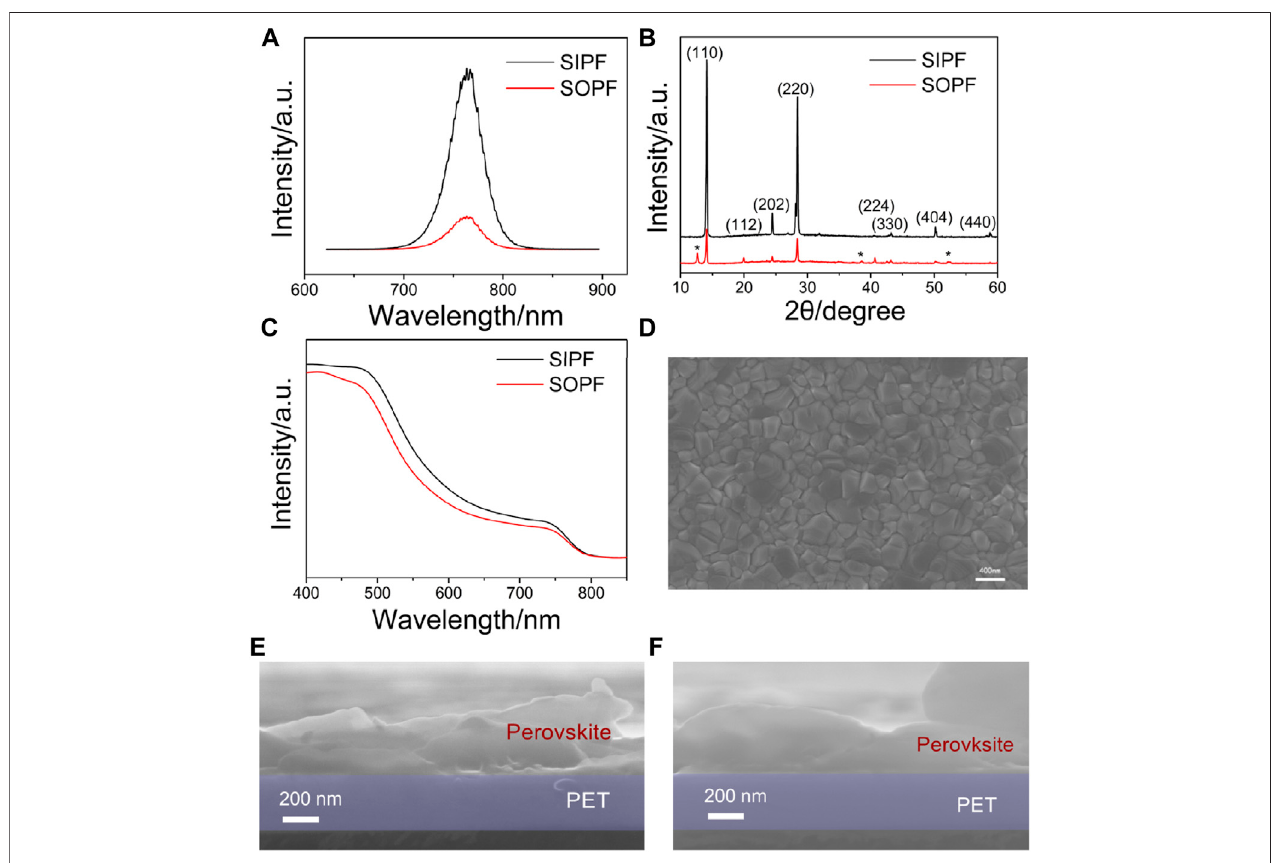
FIGURE 1 | Characterization of the constructed perovskite thin fi lm based on the solvent-induced method. (A) time-resolved PL, (B) XRD, and (C) absorption spectrum. (D) top-view SEM image of the SIPF (E) and (F) cross-section SEM images for the SOPF and SIPF fi lms.